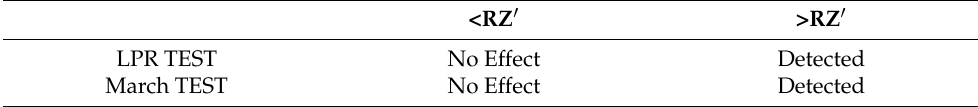
Table 4. Effectiveness of the different test methods with respect to R3.